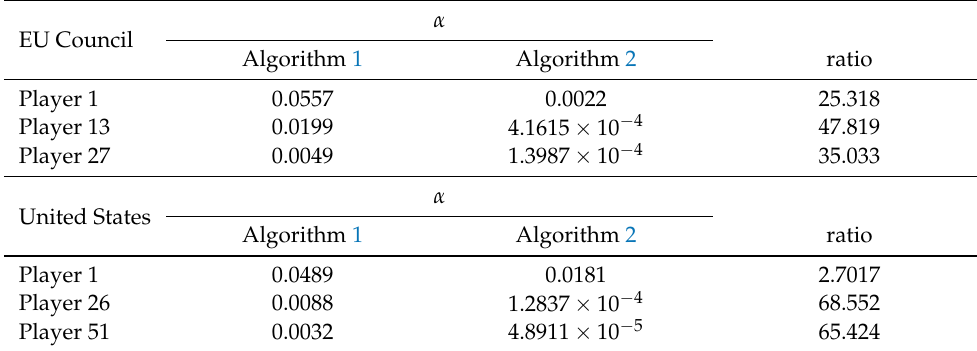
Table 2. Comparison of Algorithms 1 and 2.